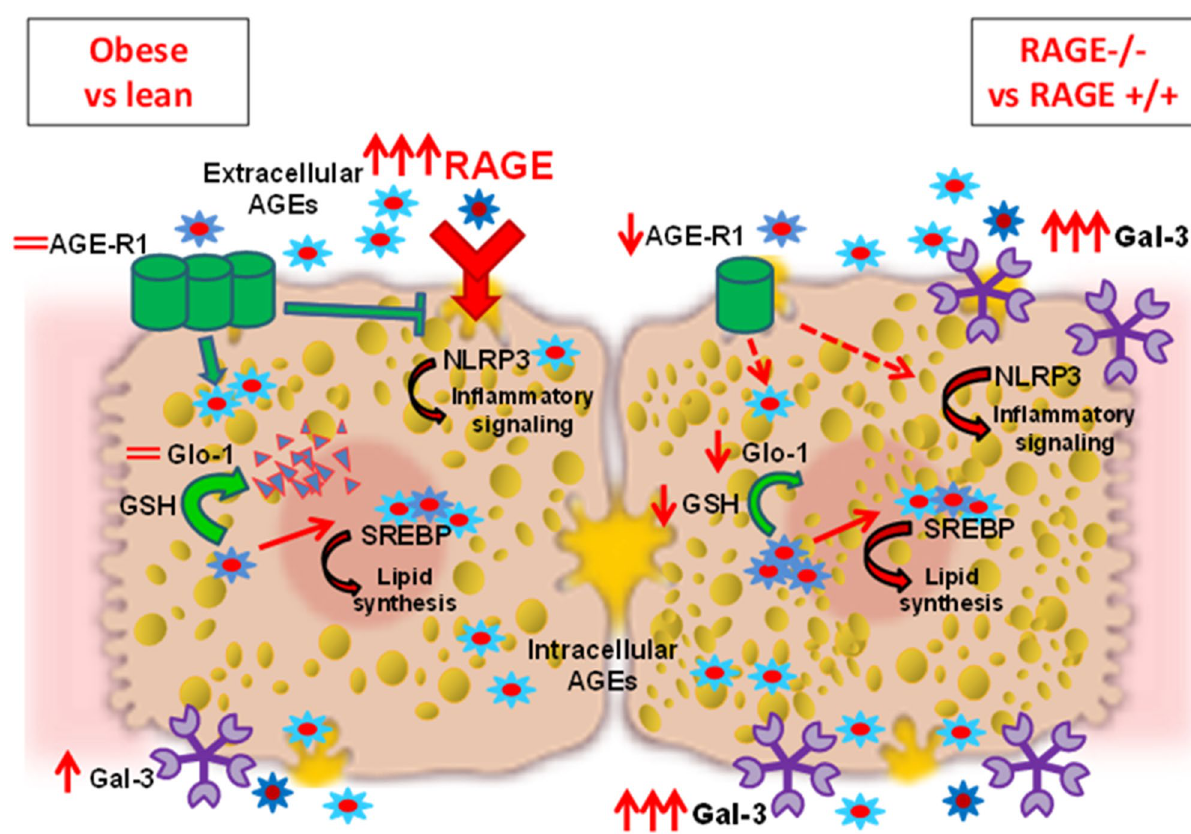
Figure 6. In healthy conditions, physiological levels of circulating AGEs bind to RAGE in the liver evoking a pro-inflammatory signaling. This effect is counteracted by the AGE-receptor-1 (AGE-R1) that competes with RAGE for AGEs binding and causes internalization and degradation of AGEs. The formation of endogenous AGEs is also inhibited by glyoxalase-1 (Glo-1) which detoxifies the AGE precursor methylglyoxal using reduced glutathione (GSH) as cofactor. In the liver of obese mice (RAGE+/+LeptrDb−/−) (left side of image) AGEs are produced in larger amounts and accumulate intracellularly. The expression of RAGE is greatly increased leading to activation of the NLRP3 inflammatory pathway. The presence of the alternative AGE receptor Gal-3 is enhanced, but the detoxifying systems are not induced. The excess of intracellular AGEs activates the de novo lipid synthesis by interfering with the activity of the sterol regulatory element binding protein 1c (SREBP1c), contributing to hepatosteatosis. When RAGE is deleted in the obese background (RAGE−/− LeptrDb−/−) (right side of image), expression of galectin-3 (Gal-3) is further increased and is likely to be involved in a compensative AGEs trapping from the circulation and AGEs-induced NLRP3 inflammatory signalling. The lacking of RAGE is also associated in the liver with reduced AGE-R1 expression and Glo-1 activity that fail to detoxify intracellular AGEs, thus contributing to the maintenance of high hepatic AGEs levels, and prolonging SREBP1c activation and lipids accumulation. Thus, the deletion of RAGE fails to prevent AGE accumulation, hepatosteatosis and inflammation in obese mice, due to alterations of other AGE-receptors and impairment of AGE-detoxifying